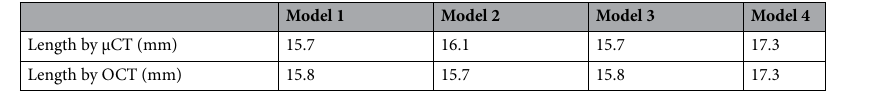
Table 3. Comparison of the length of the 3D reconstructed stents by OCT and